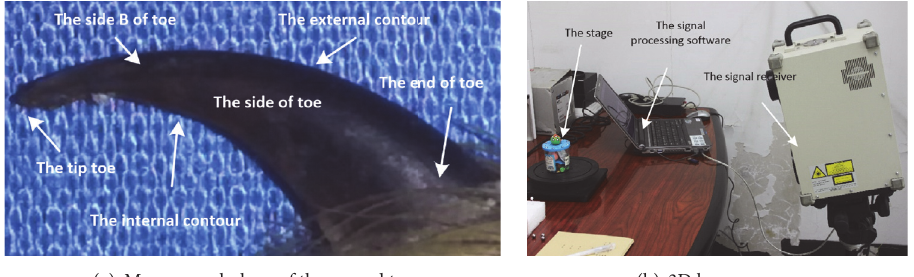
Figure 3: Himalayan marmot’s second toe and scanning equipment.